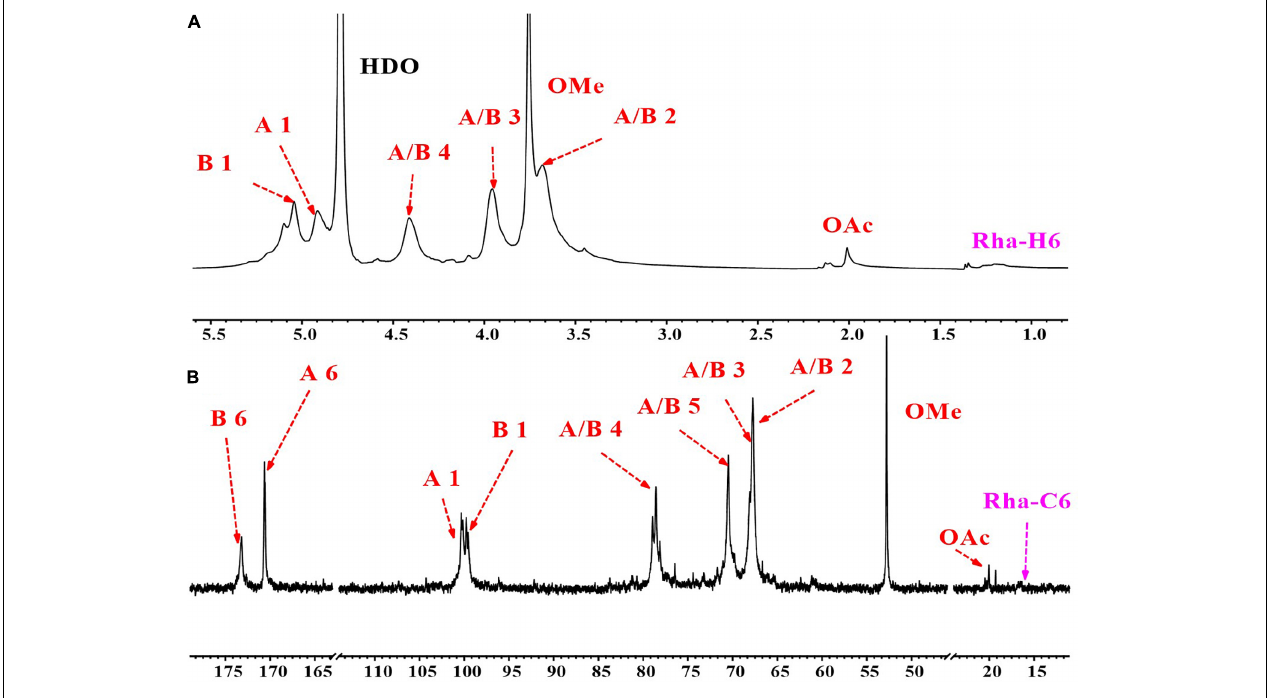
FIGURE 4 | 1D nuclear magnetic resonance (NMR) spectra of GPS2b. (A) 1 H NMR spectrum; (B) 13 C NMR spectrum.